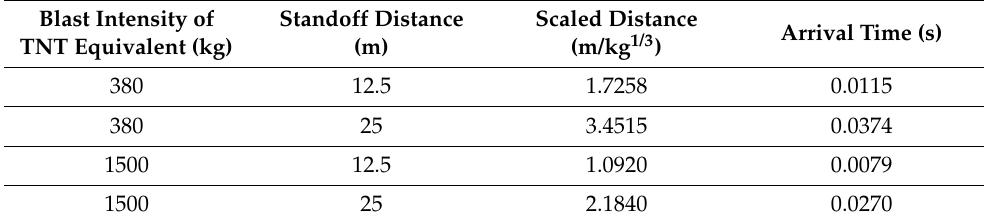
Table 2. Scaled distance and arrival time of the analysis carried out.